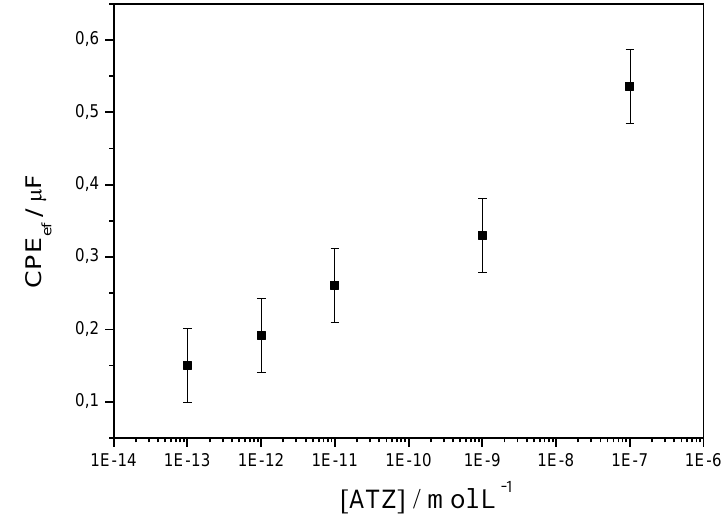
Figure 16. CPE as a function of ATZ concentration, from electrochemical impedance ef spectroscopy (EIS) experiments, on a poly(JUG-HATZ/α-ATZ)-modified electrode. Results obtained for an offset potential of −0.5 V vs . SCE